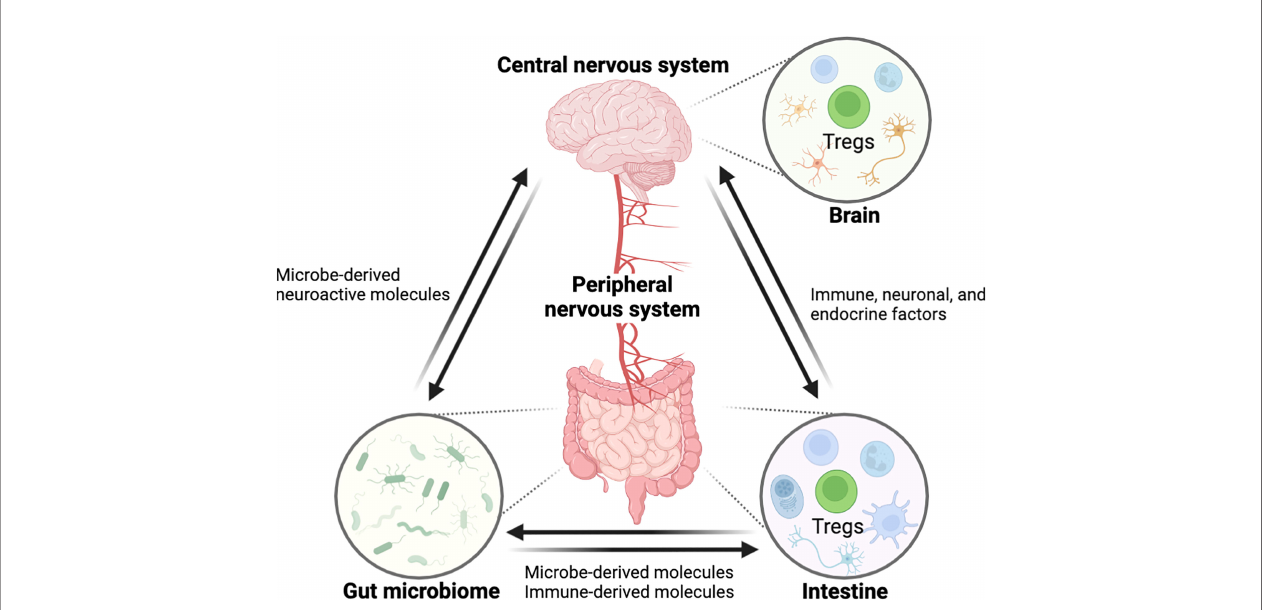
FIGURE 1 | Schematic overview showing the interaction between the GI tract and the CNS through the ‘ gut-brain axis ’ . The central nervous system is connected with the intestine by the peripheral nerves for reciprocal interaction and tissue homeostasis in which immune cells including Tregs are involved in this entangled inter-organ communication. Immunological factors, produced by gut immune cells, can regulate the nerves innervating to the intestine, eventually affecting the CNS function. In the opposite direction, neurological factors such as neurotransmitters can act on the gut immune system. Furthermore, the gut microbiome can modulate the gut-brain axis by microbe-derived molecules. In these processes, Tregs may act as a critical regulator of pathophysiology along the gut-brain axis. (All fi gures in the review were created with